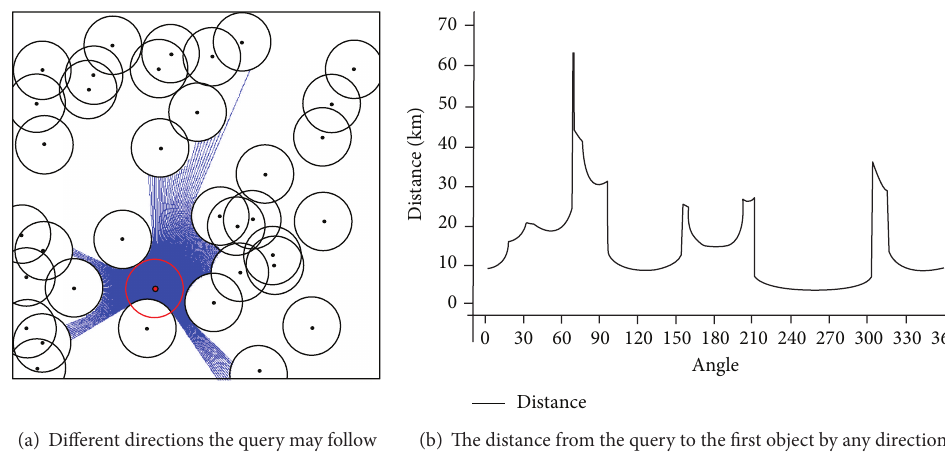
Figure 12: Distance of the closest object in all directions from the